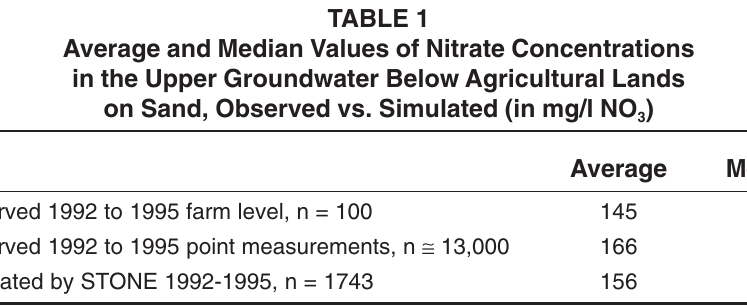
Average and Median Values of Nitrate Concentrations in the Upper Groundwater Below Agricultural Lands on Sand, Observed vs. Simulated (in mg/l NO